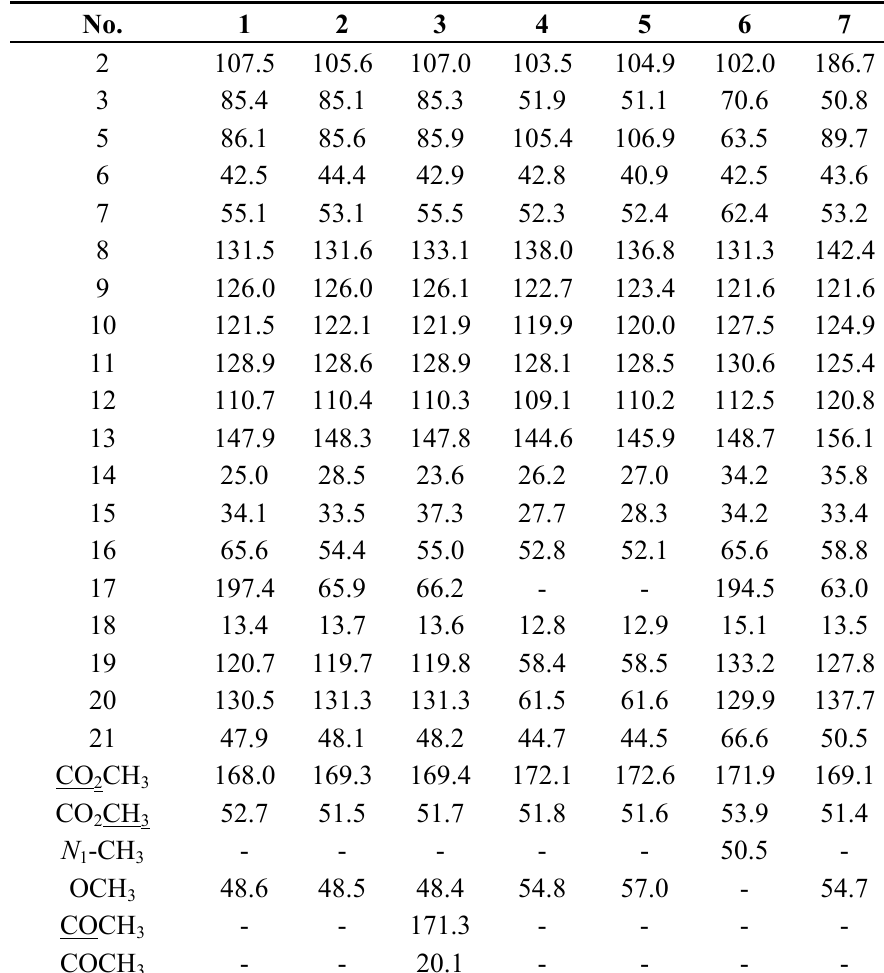
Table 1. 13 C-NMR data of compounds 1 – 7 in CDCl